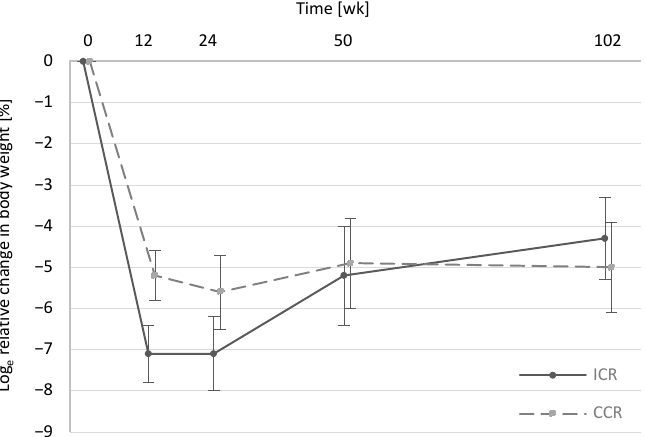
Figure 1. Relative changes in body weight by study group from baseline to wk102. Data are shown as means of log e percentage changes ± standard error of log percentage changes, with baseline values as the reference for ICR ( n = 49) and CCR ( n = 49). Intention-to-treat statistical analyses were performed using a linear mixed model adjusted for age and sex. There were no significant differences ( p > 0.05) between the intervention groups. Results on anthropometric parameters including body weight at baseline (wk0) and wk12, wk24 and wk50 have been published in detail before [13]. Body weight from these time points is shown here again to facilitate a better interpretation of body weight at the 2-year follow-up assessment (wk102). CCR, continuous calorie restriction; ICR, intermittent calorie restriction.